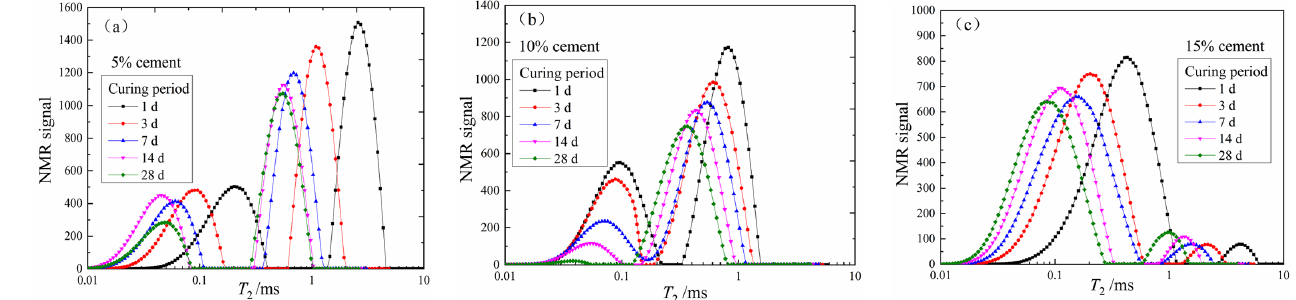
Figure 3. The T 2 distribution curves of three groups of specimens: ( a ) 5% cement content, ( b ) 10% cement content, ( c ) 15% cement content.